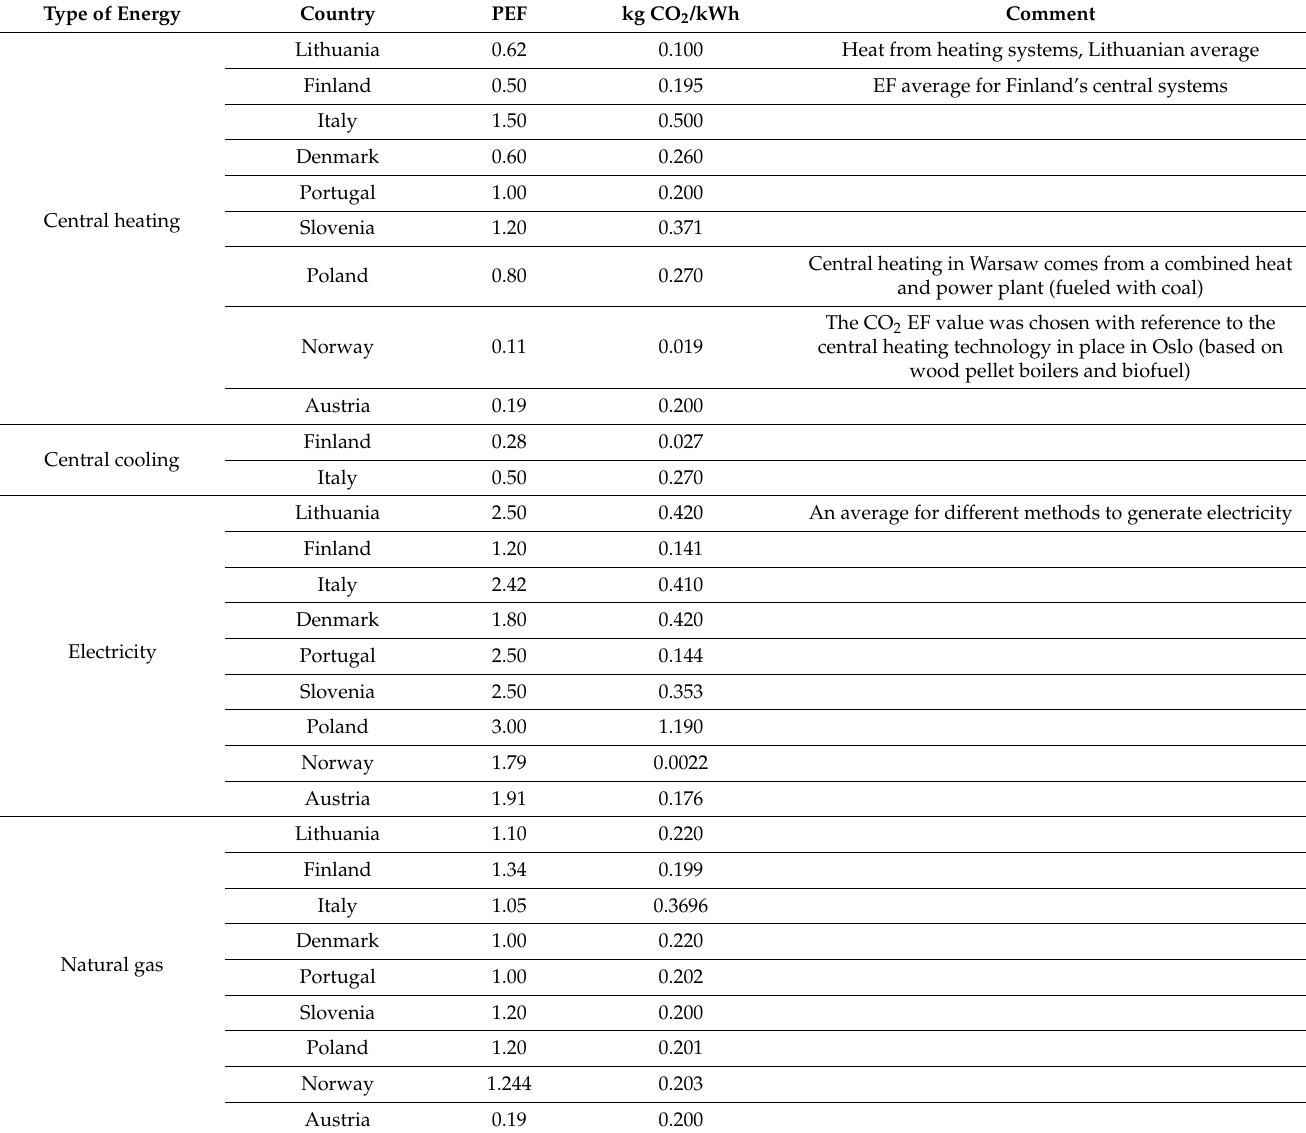
Table 9. Primary energy factors (PEF) and CO 2 emission factors (EF) in subject